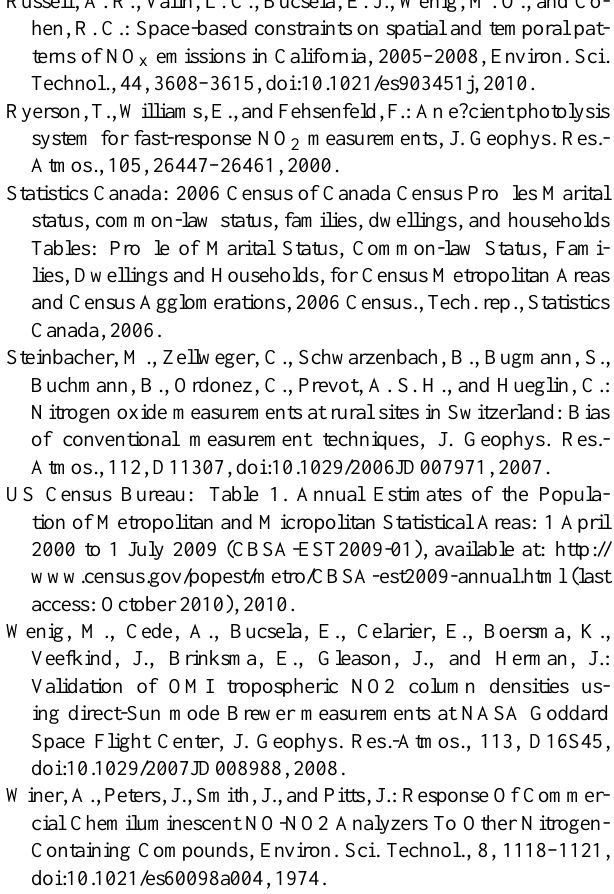
Tables: Profile of Marital Status, Common-law Status, Fami-